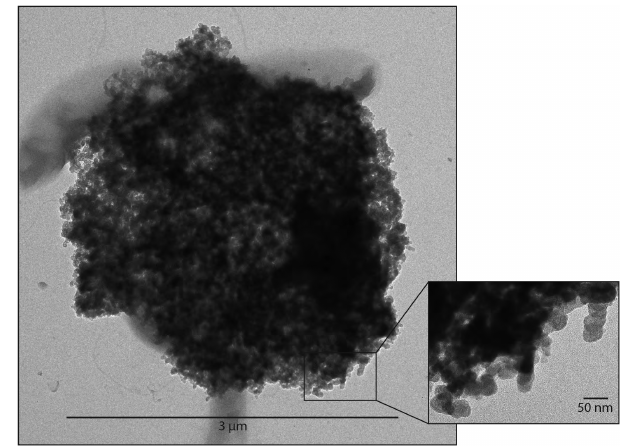
Figure 7. Aged superaggregate from Darwin rain sample collected 8 April 2014. Inset is of an enlarged section of aggregate, showing individual BC sphere